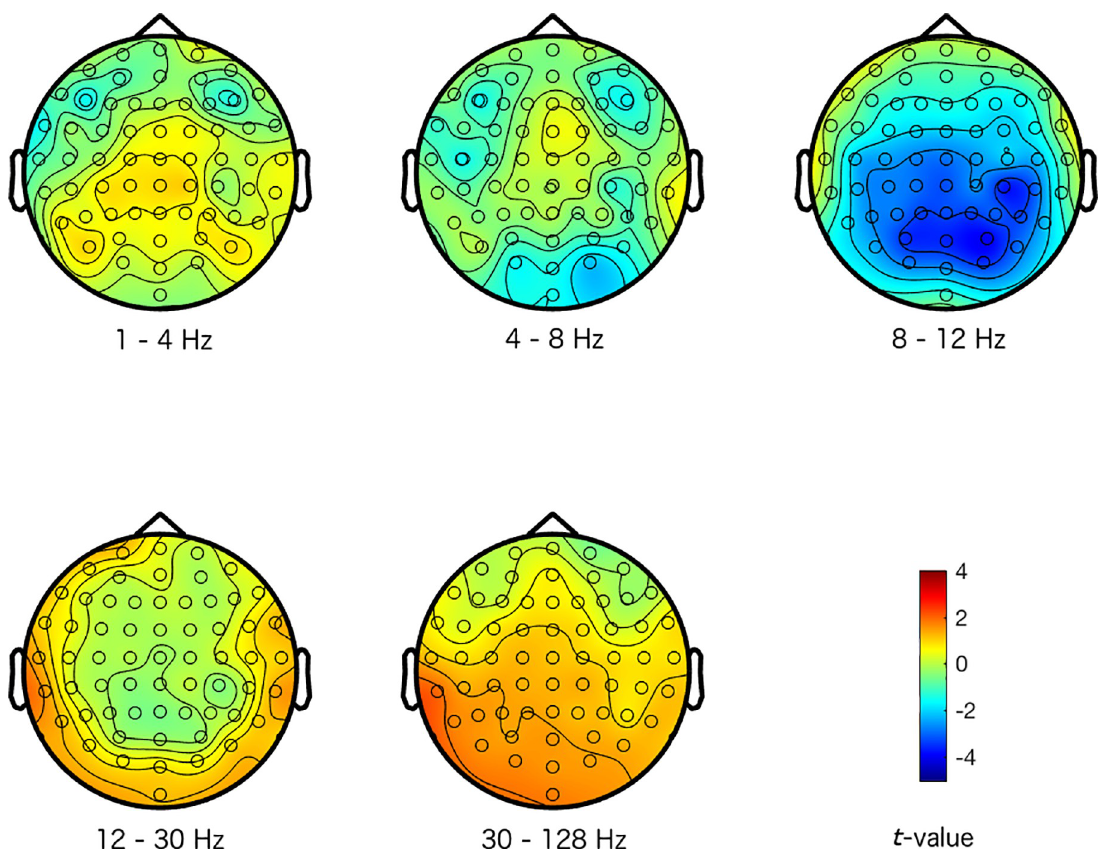
Fig 3. Maps of the difference between a fear response and the other emotional responses. The colors represent t -values. The different scalp maps show the contrast (expressed in t -values) between activity representing a fear response, and activity representing the other emotional responses for the specific frequencies that are indicated below the maps (the delta (1–4 Hz), theta (4–8 Hz), alpha (8–12 Hz), beta (12–30 Hz), and gamma (30–128 Hz) frequency range respectively), and across the head for the 64